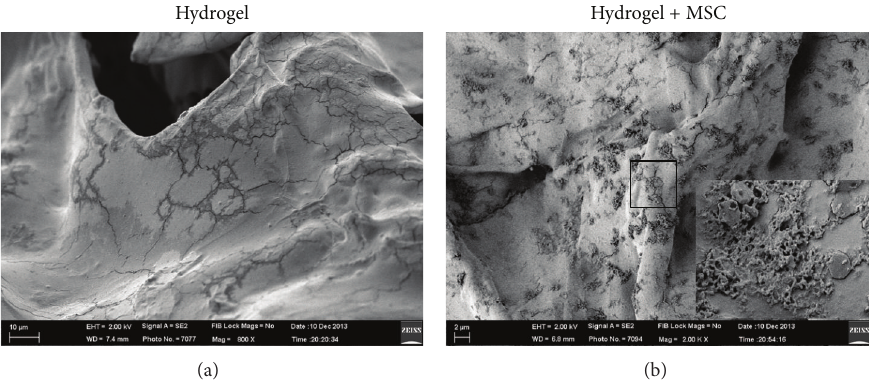
Figure 4: SEM image of Hyaluron based hydrogel alone (a). Cell attached on the surface of hydrogel